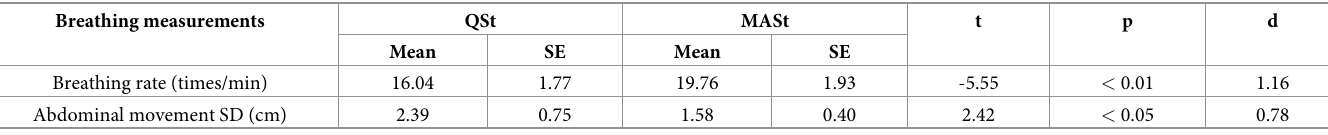
Table 2. Mean values and standard errors of breathing measurements in the quiet standing (QSt) and standing with mental arithmetic (MASt) conditions. Breathing